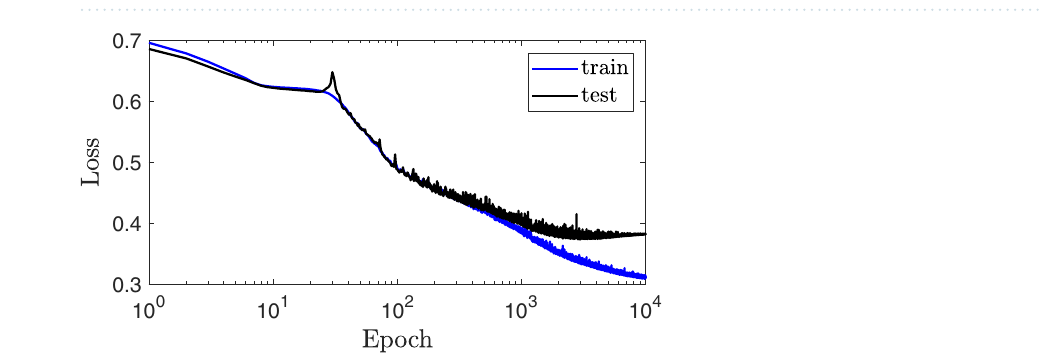
3, and the × 3. The max-pooling stride of both the × 3, which is flattened to 72 1 × ×